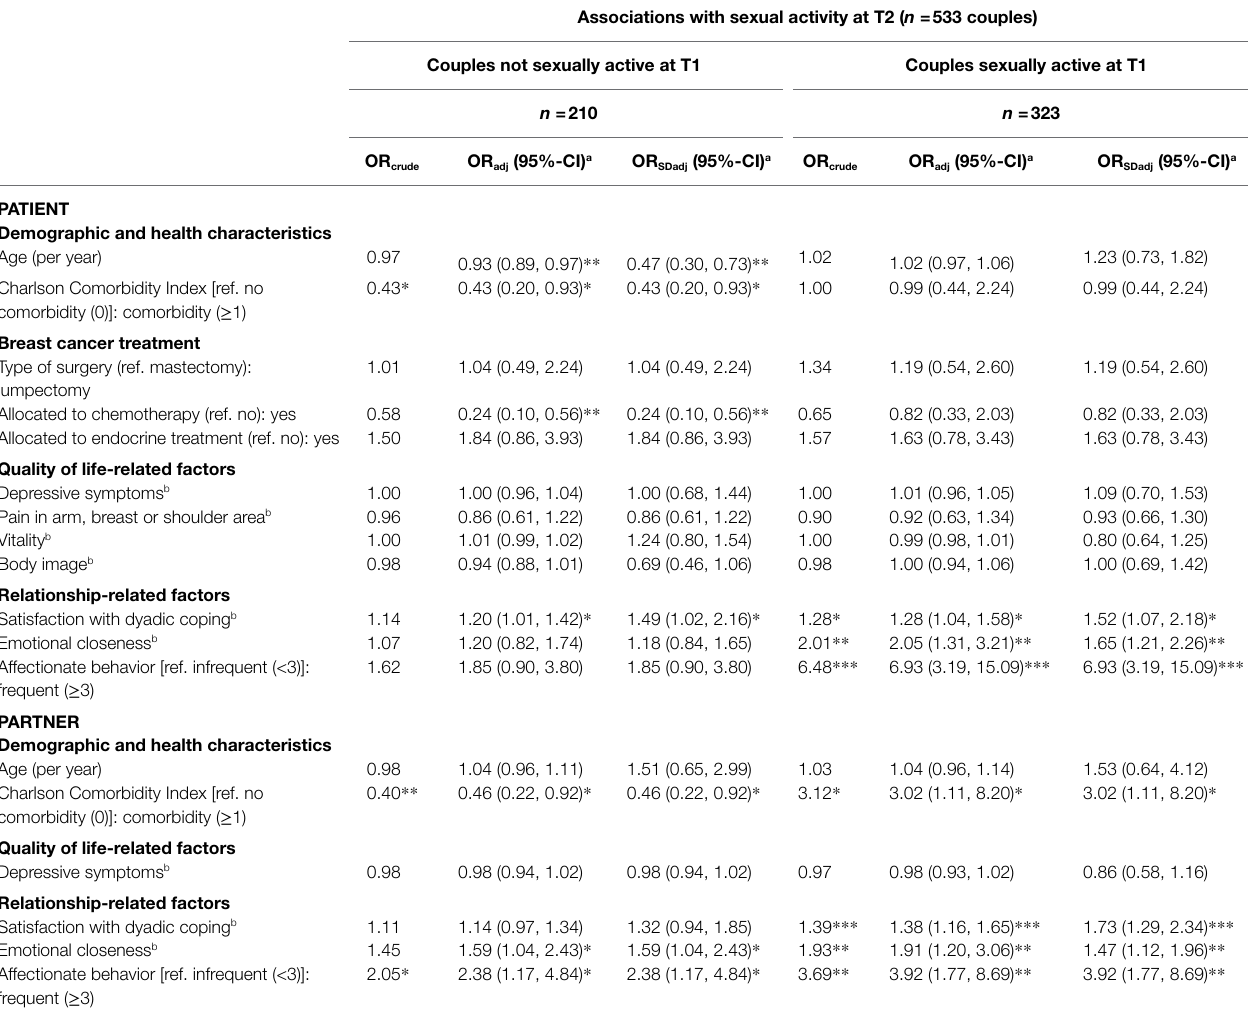
TABLE 4 | Associations between patient and partner characteristics and sexual activity at time T2, stratified on baseline sexual activity. Associations with sexual activity at T2 ( n = 533 couples) Couples not sexually active at T1 Couples sexually active at